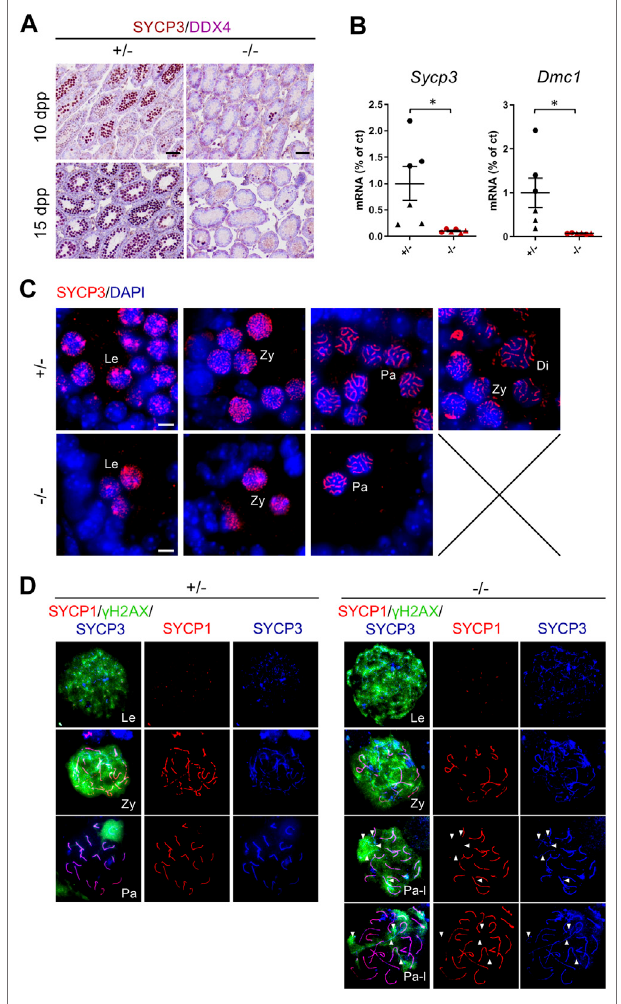
FIGURE 6 | Meiotic progression is impaired in Cep250 -/- mutants. (A) Histological analysis of 10 dpp and 15 dpp testis sections stained for the meioticmarker SYCP3(brown)and thegerm cellmarkerDDX4 (purple). Scale bar: 50 µm. (B) Sycp3 and Dmc1 mRNA expression levels were measured by RT-qPCR in the post-natal testes. Triangles represent 10 dpp values and circles represent 15 dpp values. β -actin was used as an endogenous reporter. Data are expressed as a percentage of the control. Mean ± SEM. * p < 0.05 (two-way ANOVA). (C) Immuno fl uorescence analysis of SYCP3 (red) in 15 dpp testis sections. DNA is stained with DAPI. Le: Leptotene; Zy: Zygotene; Pa: Pachytene; Di: Diplotene. Scale bar: 5 µm. (D) Co-immunolabelling of SYCP3 (blue), SYCP1 (red) and γ H2AX (green) on the spermatocyte chromosome spreads. Le: Leptotene; Zy: Zygotene; Pa: Pachytene; Pa-l: Pachytene-like. White arrowheads indicate asynapsis (SYCP3-stained axes, unstained for SYCP1).